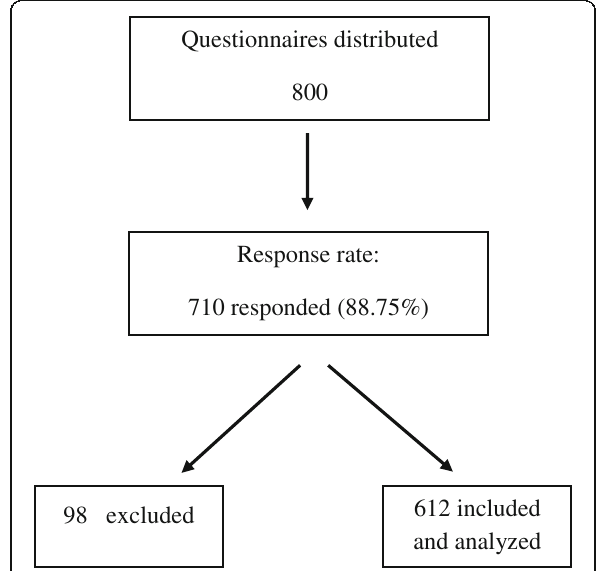
Fig. 1 Flow chart showing the data collection